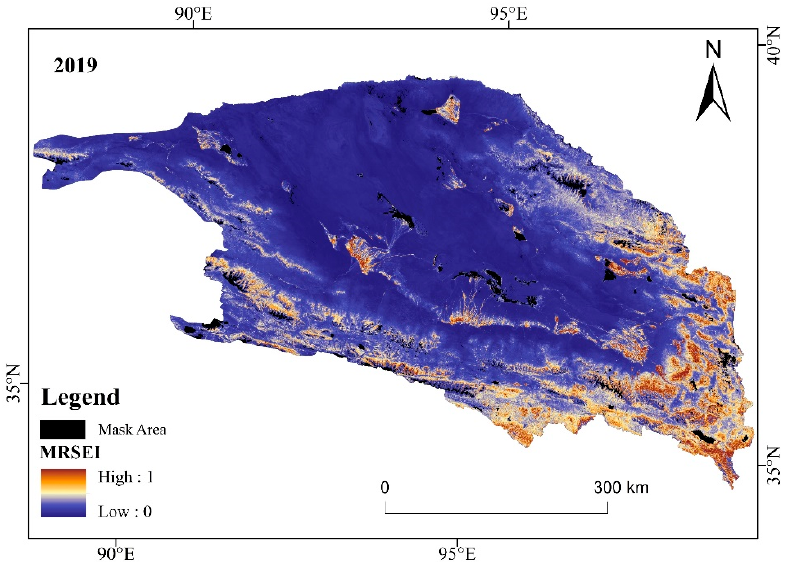
Figure 6. Spatial distribution of MRSEI in Qaidam Basin, 2019.